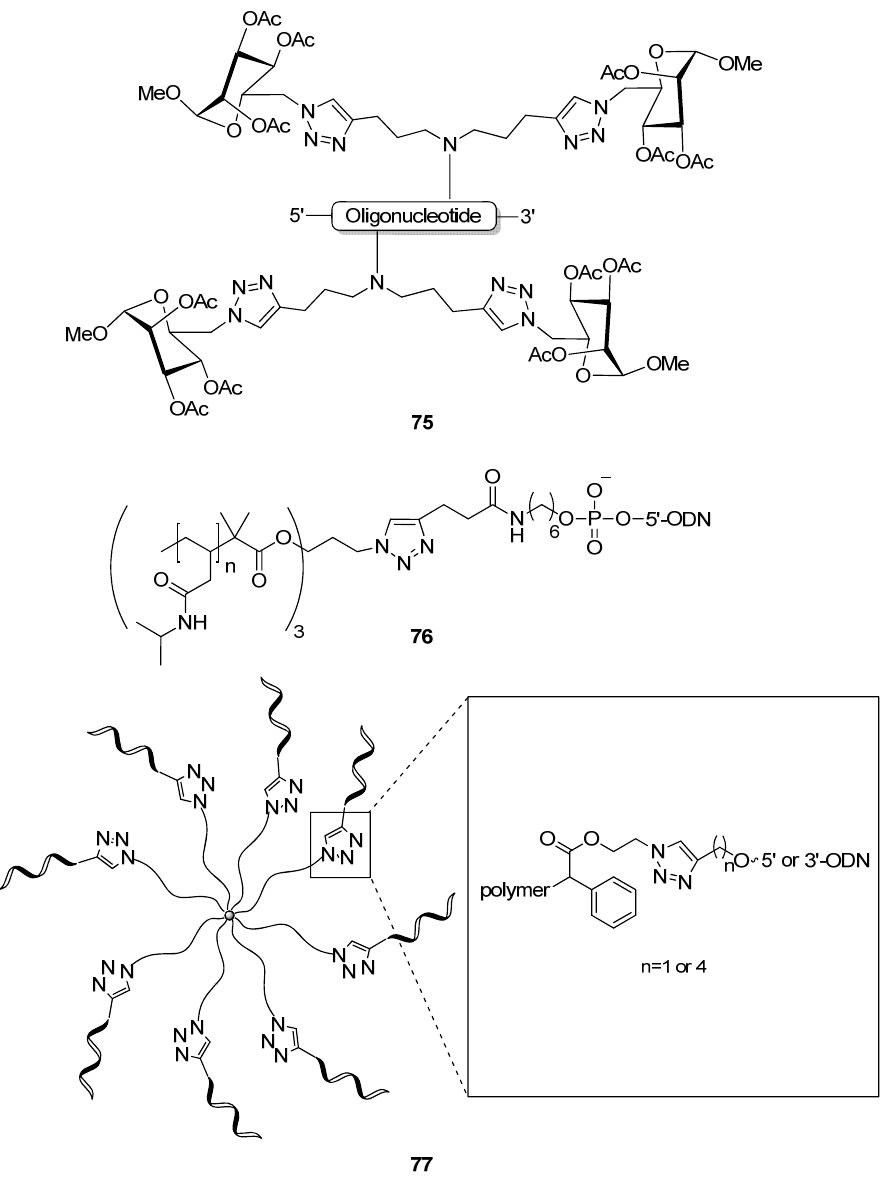
Figure 12. Various structures of triazole-linked oligonucleotide